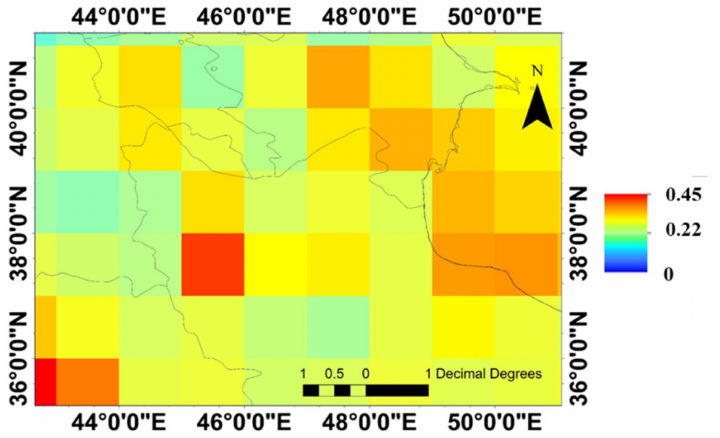
Figure 7. Spatial distribution of MODIS/Aqua mean AOD from 2000 to